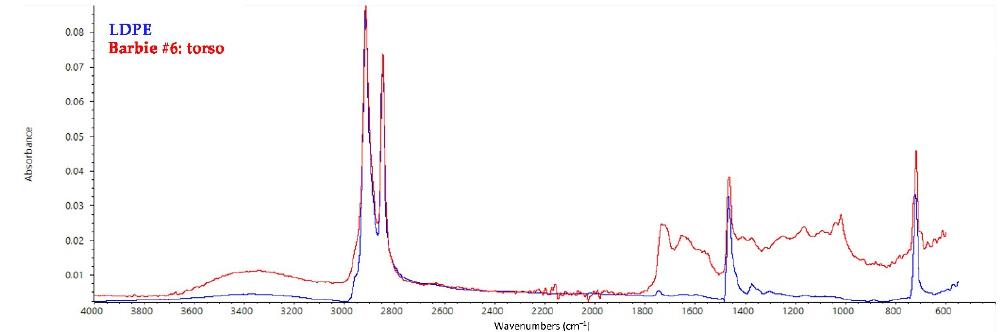
Figure 4. FT-IR ATR spectrum collected on the torso of Barbie #6 and shown as a model spectrum of LDPE elements in all the other dolls, with the reference spectrum of LDPE.